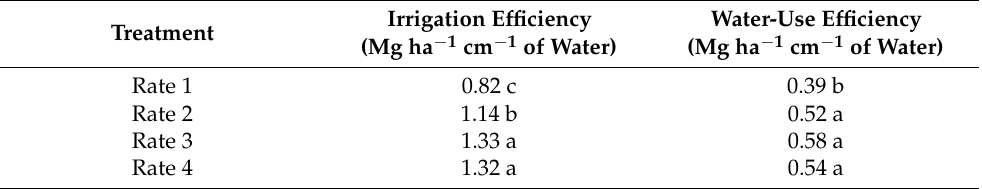
Table 5. Effects of irrigation rate on irrigation efficiency (IE) and water-use efficiency (WUE) for producing marketable yield in 2018. Within each year and efficiency type, numbers followed by different letters are significantly different at α = 0.05.